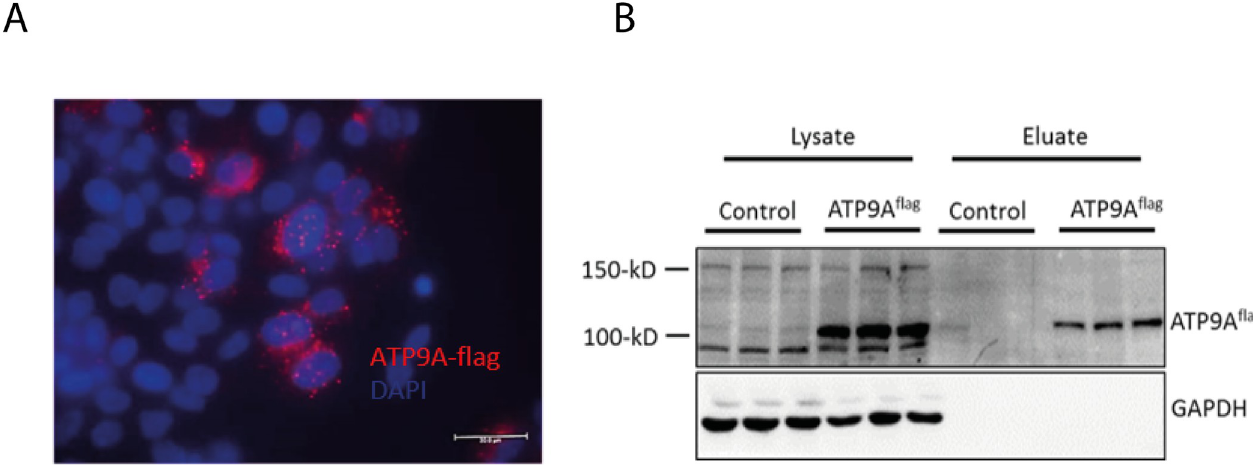
Fig 3. ATP9A localizes to intracellular vesicles and to the plasma membrane. Immunostaining and surface biotinylation was performed in ATP9A-flag overexpressing HepG2 cells to study the localization of ATP9A. (A) Immunostaining of ATP9A-flag (red) in HepG2. Nuclear DAPI staining in blue. (B) Surface biotinylation of ATP9A-flag in over-expressing HepG2 cells. Immunoblot showing ATP9A and GAPDH in the total lysate and eluate fraction.